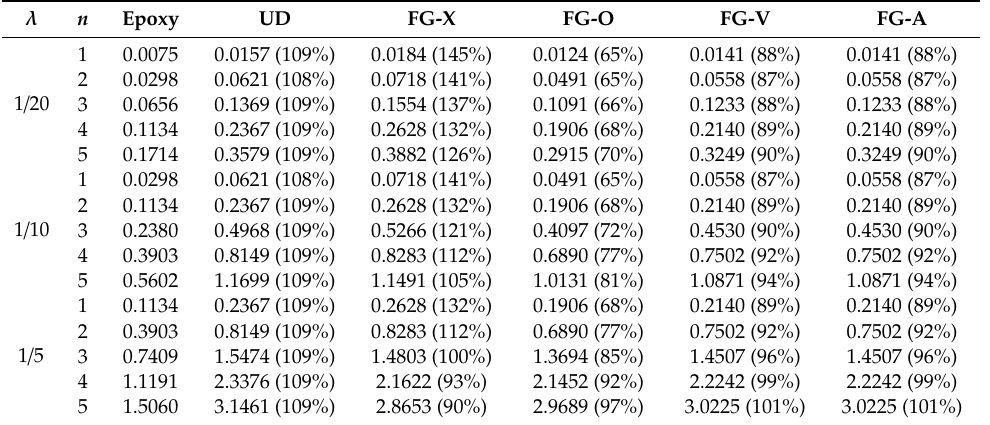
Table 4. Frequency parameter Ω of FG-GPLRC beams’ absence of magnetic fields and elastic foundation.